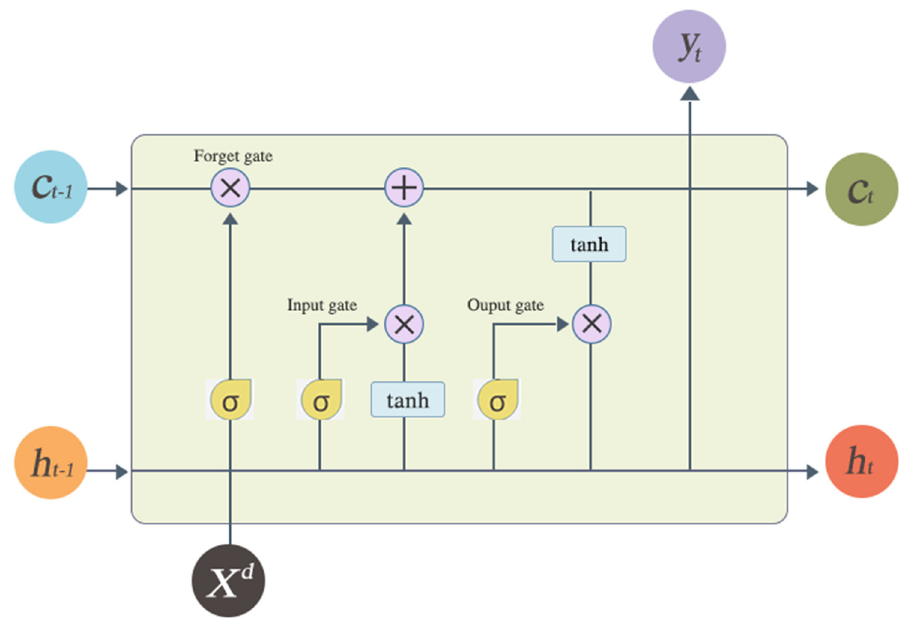
Figure 3. A standard LSTM unit.